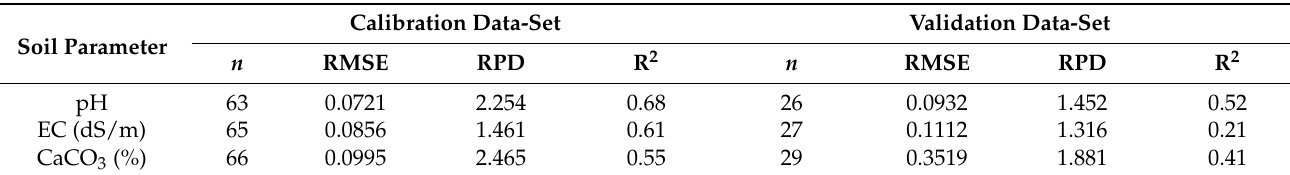
Table 5. The predictability assessment of the soil parameters using the PLSR